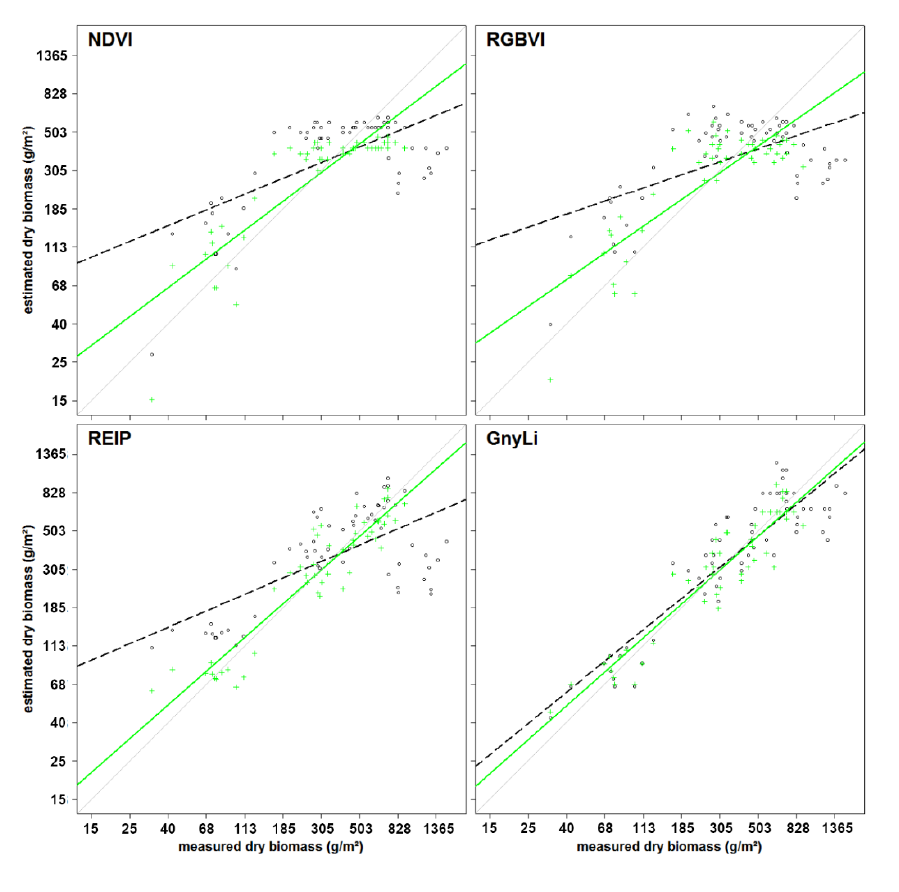
Figure 5. Scatterplots of measured vs. estimated dry biomass for one validation data set for NDVI, RGBVI REIP, and GnyLi (exponential model). Pre-anthesis: crosses and solid green line; whole observed period: circles and dashed black line; 1:1 line: light